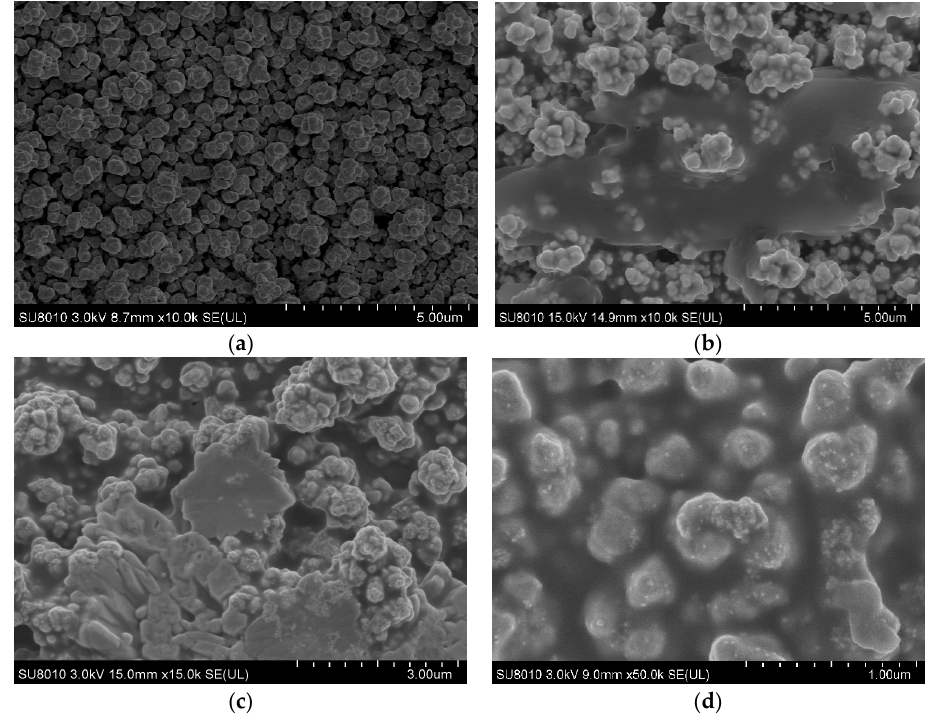
Figure 3. The scanning electron microscope (SEM) image of ( a ) gold nanoparticles (AuNPs with diameter of approximately 500 nm) modified SPE, ( b ) molybdenum disulfide/gold nanoparticles (AuNPs/MoS 2